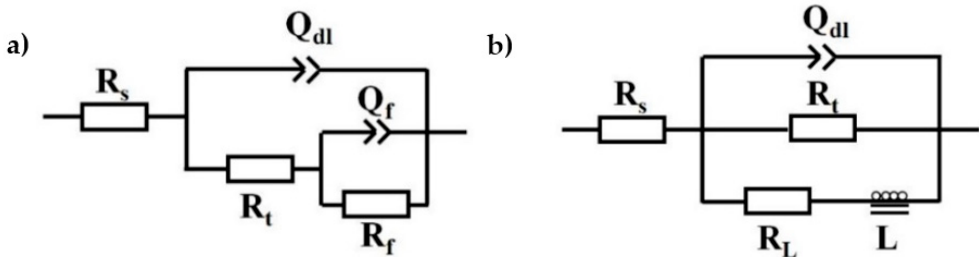
Figure 5. Equivalent circuits for the Mg-8%Li alloy pre-immersed in different NaCl solutions for different time: ( a ) 0 h and 4 h in 0.9 wt.% NaCl solution, 0 h in 3.5 wt.% NaCl solution, ( b ) 8 h and 24 h in 0.9 wt.% NaCl solution, 4 h, 8 h and 24 h in 3.5 wt.% NaCl solution.